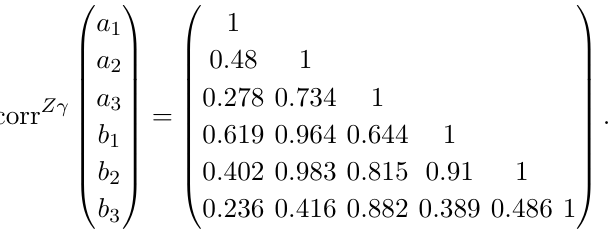
(cid:0) (cid:1) a 2 in the fit